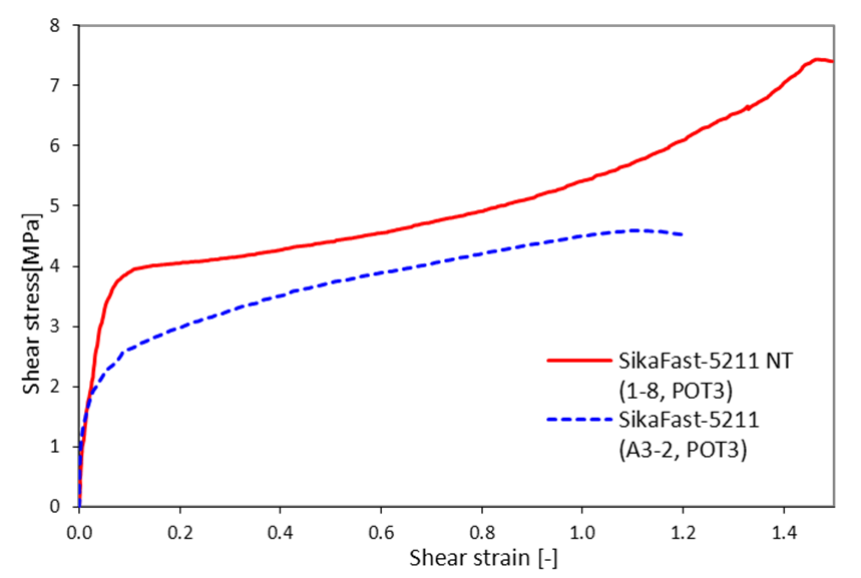
Fig. 4 Comparison of acrylate SikaFast-5211 a SikaFast-5211 NT in glass-to-steel connection.